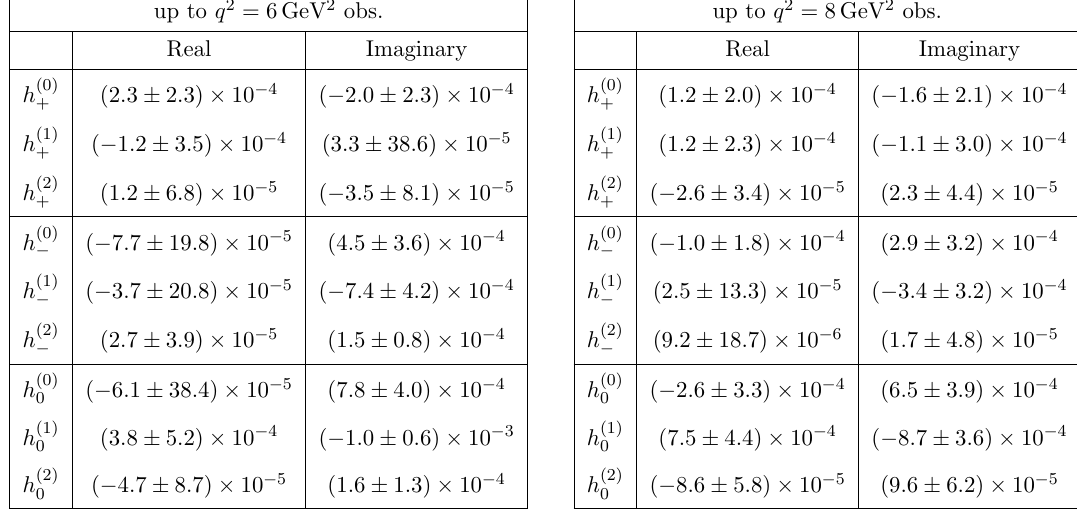
up to q 2 = 6GeV 2 obs.